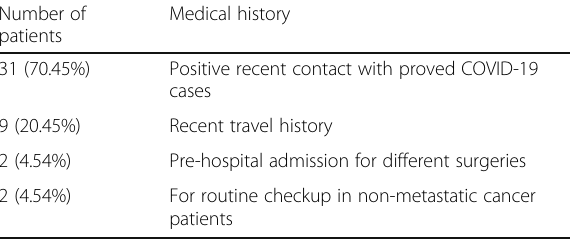
Table 1 Clinical history of patients enrolled in the study Number of